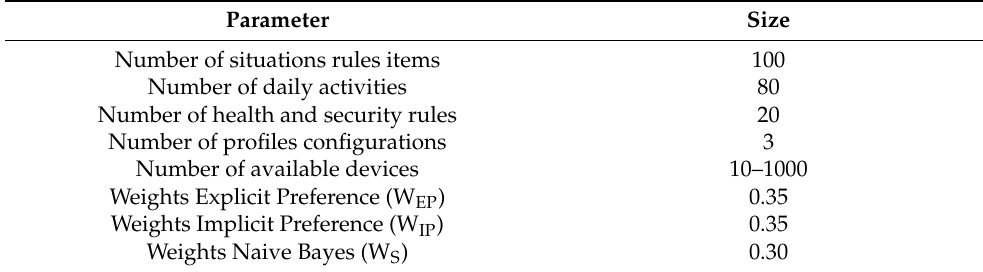
Table 6. Configuration